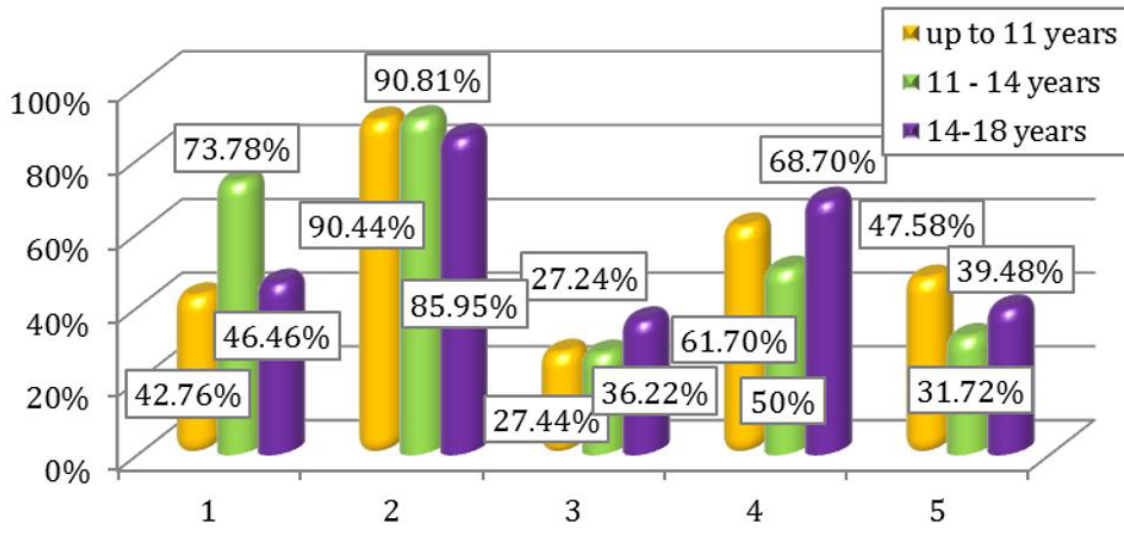
Figure 3. Affirmative answers to questions 1-5 of Questionnaire I according to age.